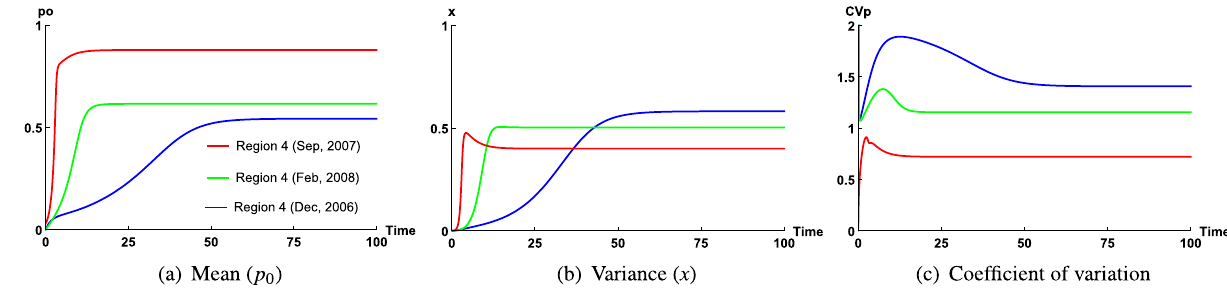
Figure 8. Time series graph of ( a ) mean ( p 0 ), ( b ) variance ( x ), ( c ) coefficient of variation of phytoplankton ( CV P ) of the closure model for Region 4 in Sep 2007, Dec 2006 and Feb 2008 respectively. These figures represent how seasonal variation affect CV P at the depth of 50 m of Region 4 (inside Tokyo Bay), where range of ε remains (0.035, 0.1) when productivity is high, and (0.35, 1) when productivity is low, considering total 1.5 µ gN l − 1 is low at Region 4 in Sep 2007 and total biomass A 2 µ gN l − 1 is high at Region biomass A = = 0.4 4 in winter season, Dec 2006 and Feb 2008. The constant parameter values for this simulation are κ = 0.6 µ gN l − 1 , A 1.5 µ gN l − 1 ) in Sep 2007 and κ 2 µ gN l − 1 ) in Dec 2006 0.4 (K = 0.8 µ gN l − 1 , A ( K = = = = 0.085, 0.75, 0.95 in Sep, Feb and Dec 0.4, 0.9, 1.6 for ε and Feb 2008 and β = = plankton is comparatively high, but, quantity of concentrated biomass is higher at Region 4 than Region 2, which is also supported by higher phytoplankton productivity at Region 4 than Region 2. Nature of spread of phytoplankton is obtained from the dynamics of normalized variance x of phytoplankton, which depends on β . At a fixed depth, x increases with increasing β (Fig. 5b). For all regions where CV P < 1 , domain of ε belongs to (0.035, 0.1), β is very sensitive to half-saturation constant K and total biomass A of the system. If A decreases, then corresponding K will decrease, in this case, range of domain of β reduces. Again, for fixed biomass, if K increases, then range of β decreases.